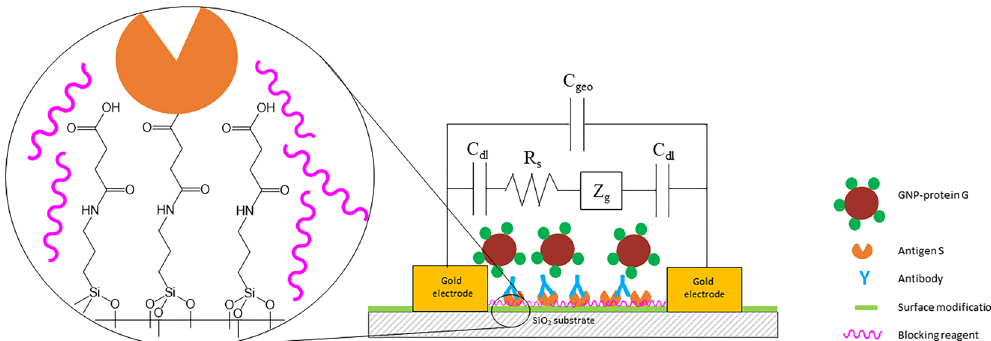
Figure 2. Schematic diagram of the affinity biosensor. Baculovirus purified S protein (antigen S) is immobilized in the gap between interdigitated electrodes. Serum antibodies to the S protein bind to the S protein. Gold nanoparticles conjugated with protein G (GNP-proteinG) bind to the antibodies, causing an impedance change. The zoomed-in area shows the silica gap between gold electrodes with surface modification details, the spike protein immobilization and the presence of blocking agents to improve impedance readings.